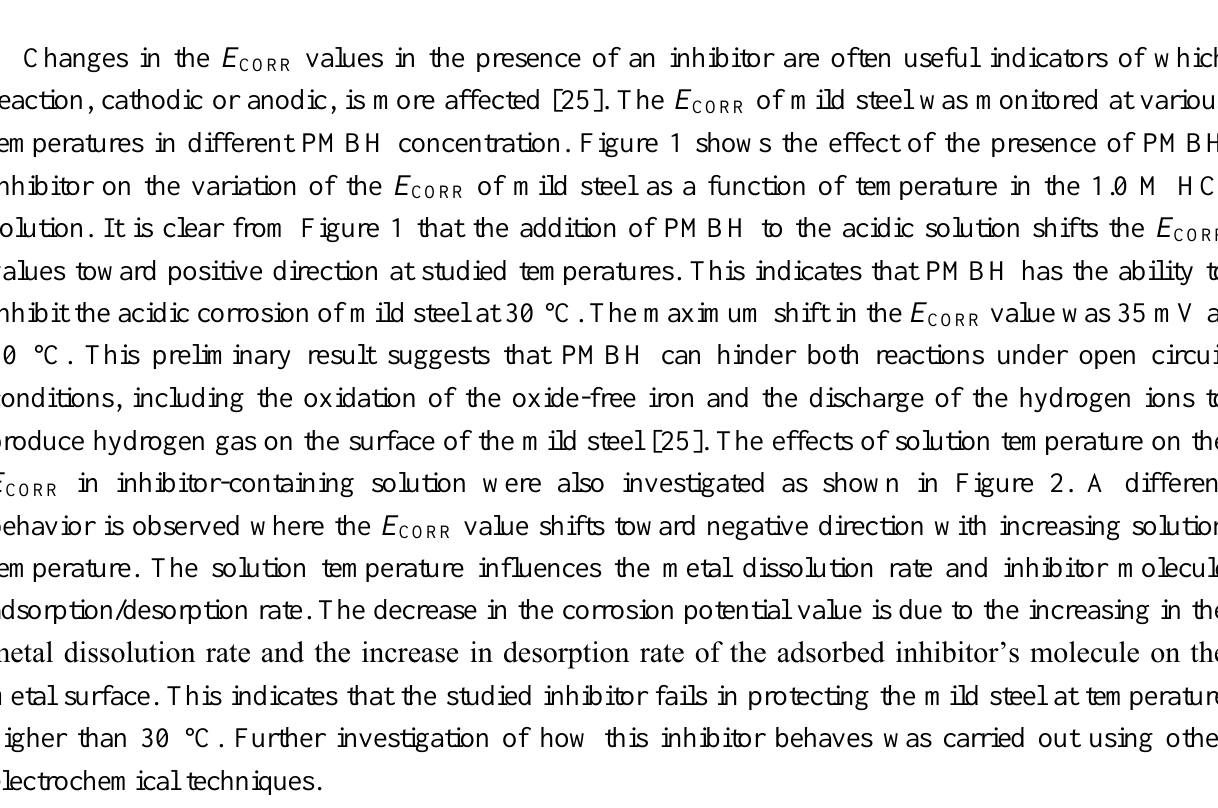
Figure 1. E values for mild steel in a HCl solution with various concentrations of CORR PMBH at 30